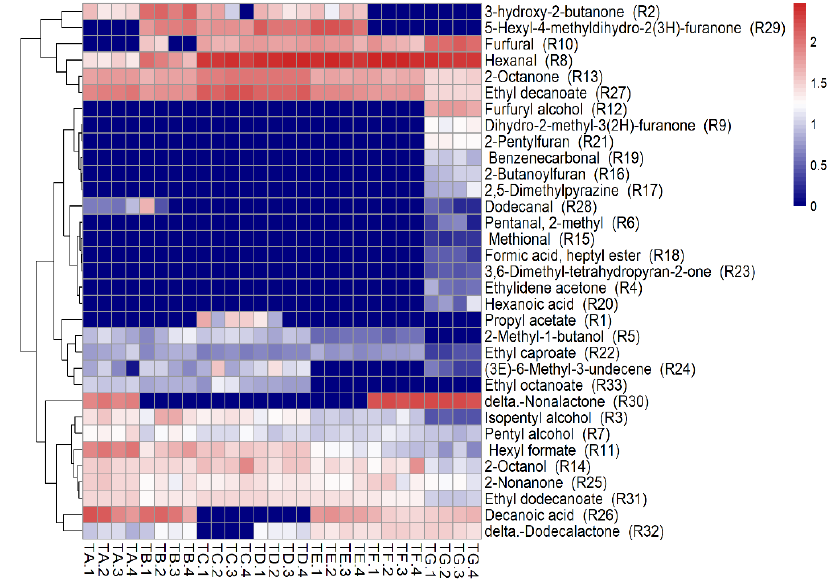
Figure 4. Heat map of the contents of the main volatile compounds during the concentration times and after sterilization. The content value increases with the color varying from blue to red. (TA1 ... 4, TB1 ... 4 to TG1 ... 4) represent samples in quadruplicate at di ff erent time points.